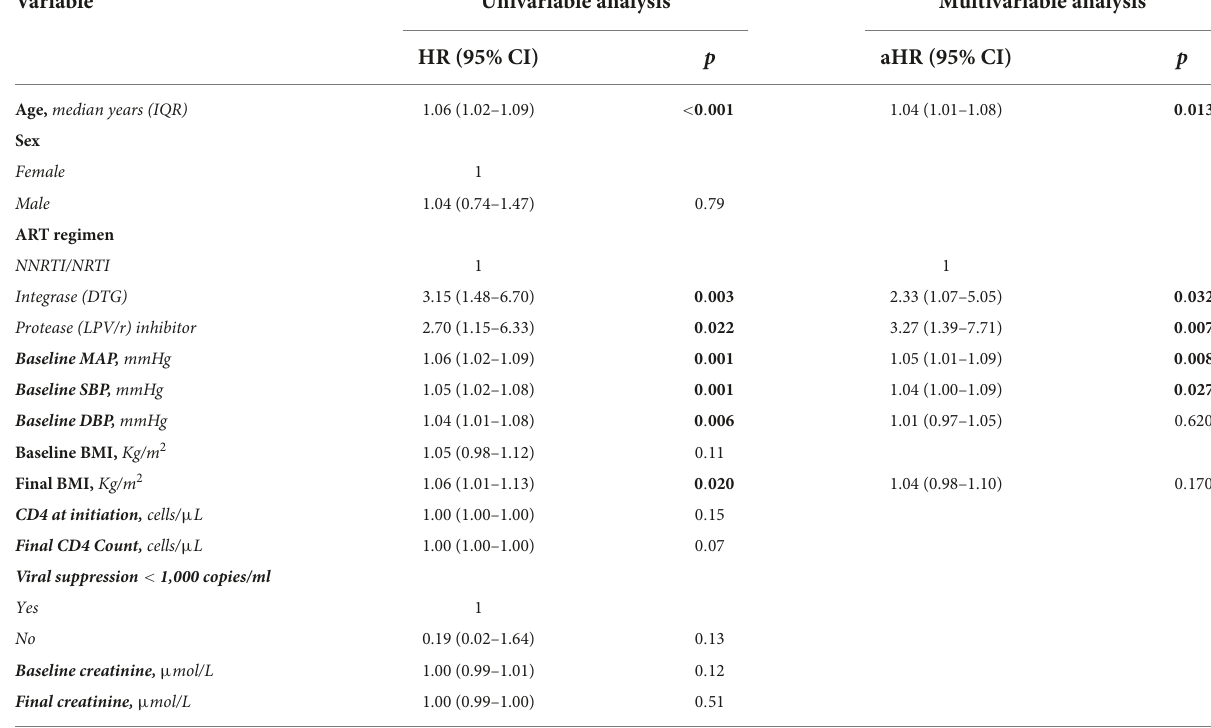
TABLE 3 Predictors of incident hypertension in persons with HIV. Variable